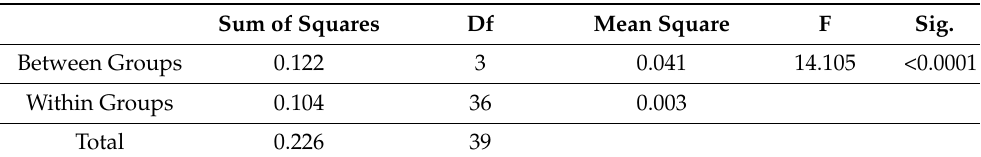
Table 7. ANOVA test for NAF of propolis treated-Hep-2 (different propolis concentrations) and control cells (24 h after treatment).